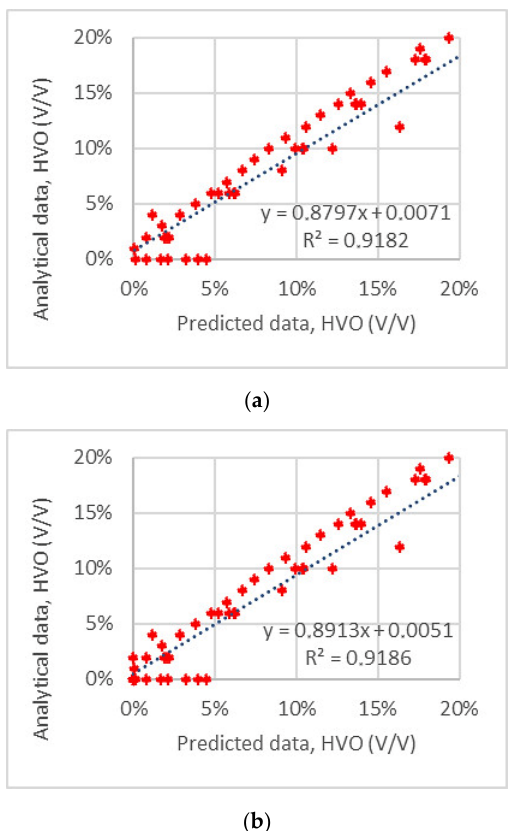
Figure 9. Analytical concentration values of all validation samples versus predicted values using HVO quantification PLS model: ( a )—PLS model predictions, ( b )—PLS model prediction with data interpretation.